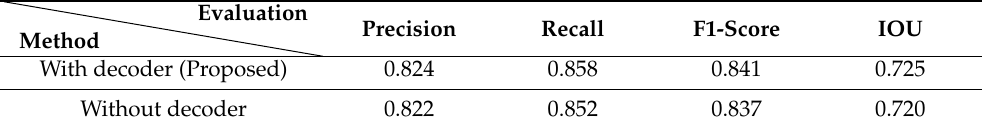
Table 8. Performance between model with decoder and without decoder. Method